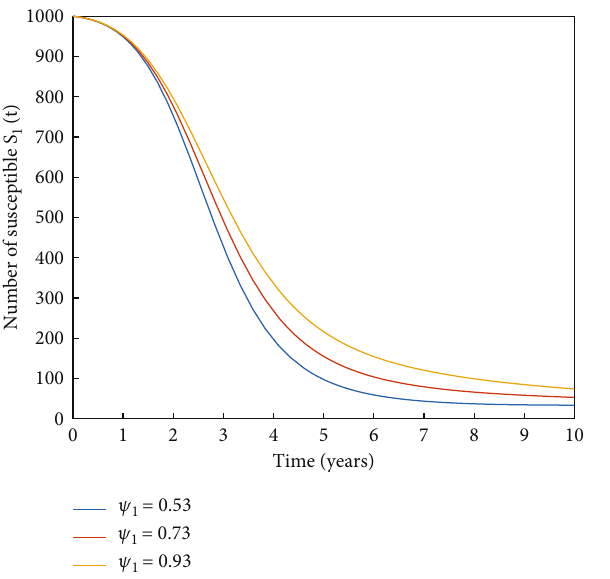
Figure 20: Transformation of susceptible individuals for recovery rate ψ 1 with various values.